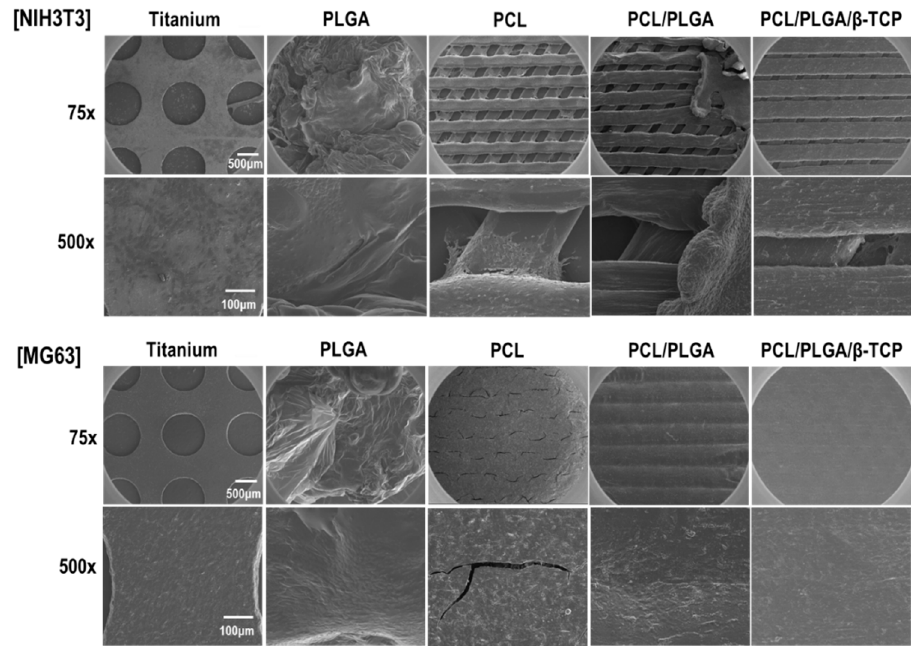
Figure 10. Scanning electron microscope images of NIH3T3 and MG63 cells on different bioresorbable membrane and on the non-resorbable titanium membrane.